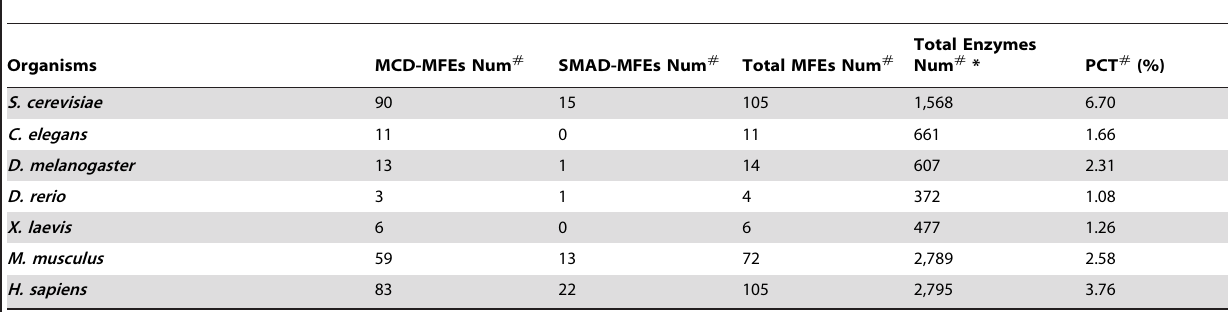
Table 4. The statistics of known MFEs in seven eukaryotic model organisms.